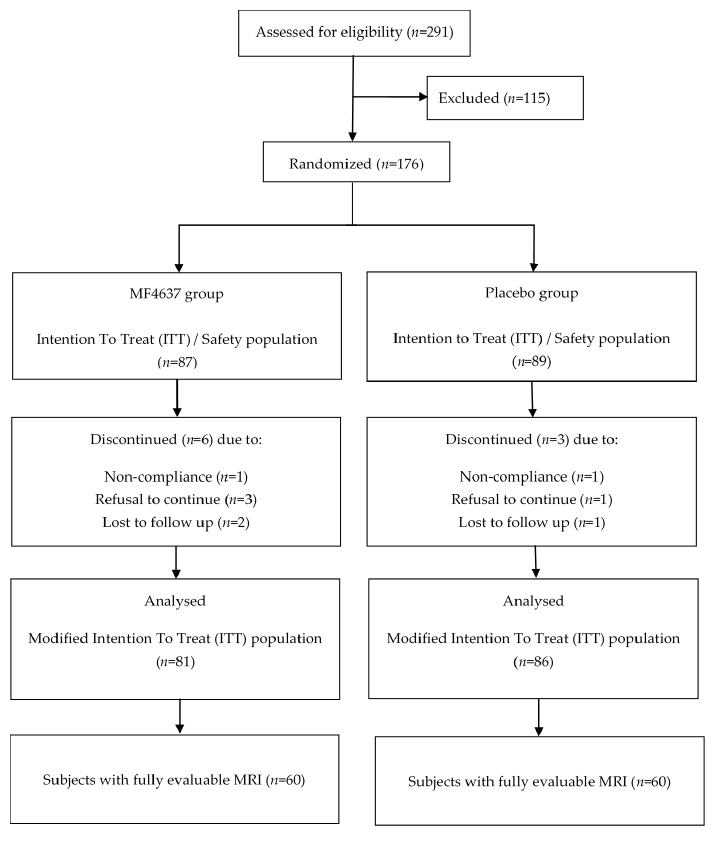
Figure 1. CONSORT flow chart of participant flow.